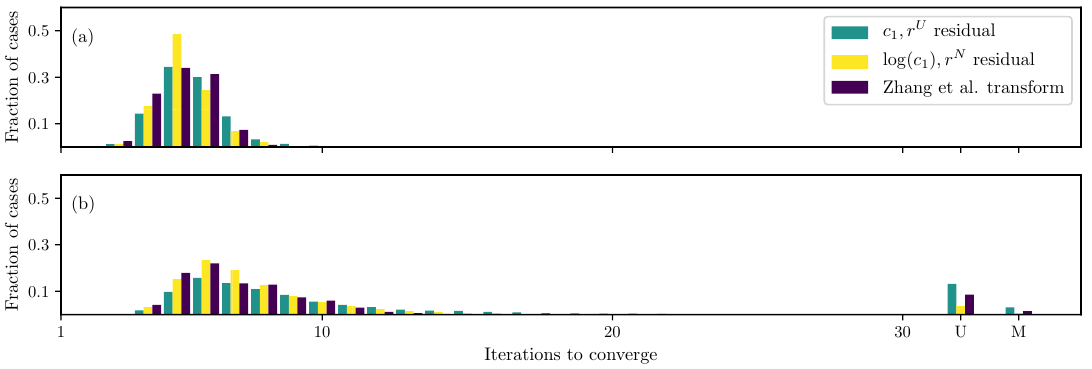
Figure 2. Iterations required using different formulations for the GOH (2) model DC case when ( a ) only c 1 and c 2 are unknown and ( b ) all parameters except the angle θ are